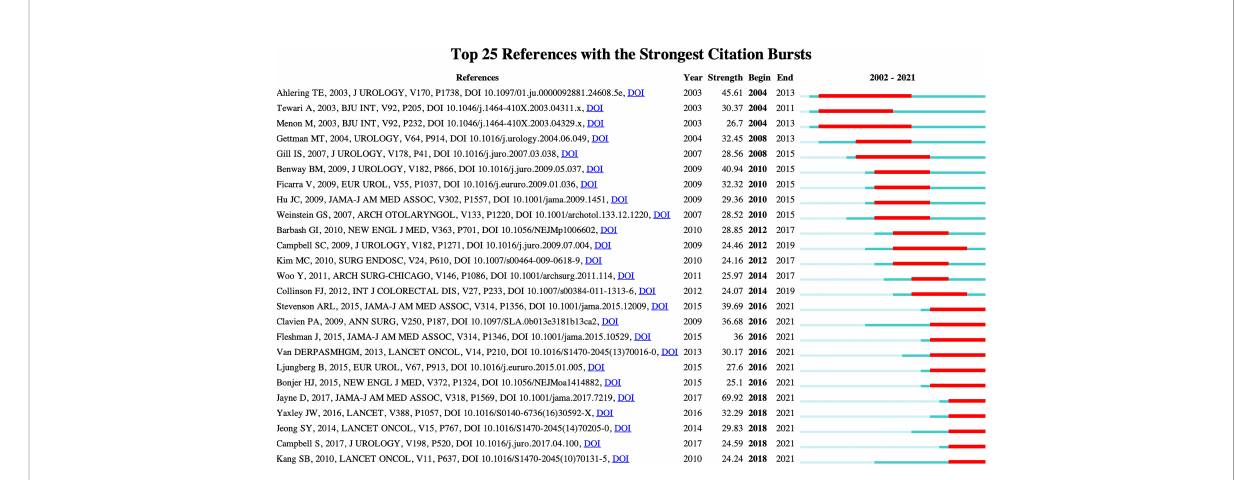
FIGURE 9 The top 25 references with the strongest citation bursts. The blue line indicates the time interval, and the red line indicates the time from the begin to the end of the citation